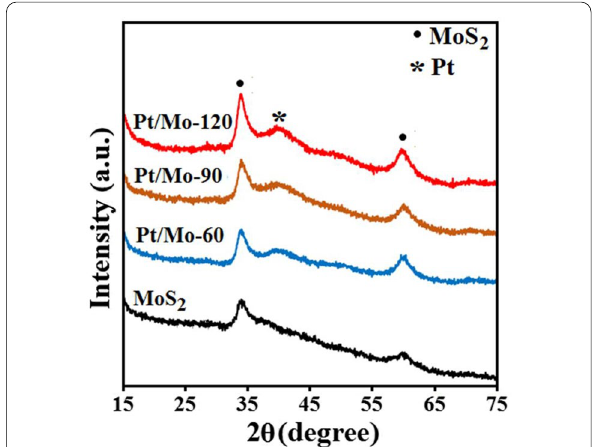
Fig.1 X-ray diffraction patterns of pure MoS 2 nanosheets and Pt/ Mo- x ( x 60, 90, 120) =